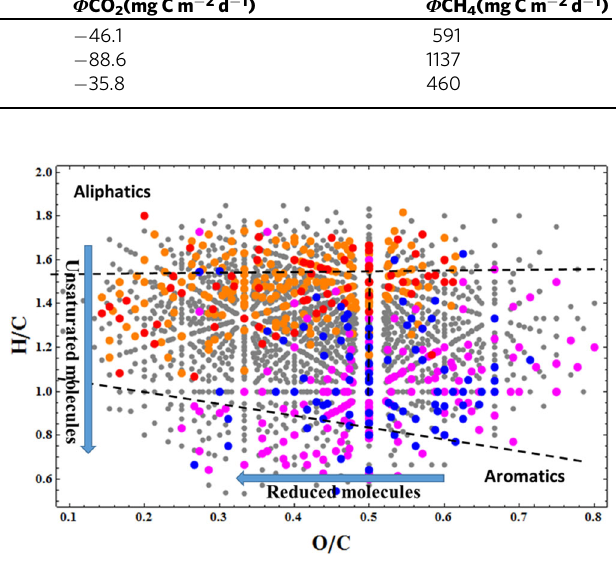
Fig. 3 Van Krevelen diagram of all SPE-DOM molecules identi fi ed with FT-ICR MS. The diagram cross-plots the hydrogen:carbon atomic ratio (H/C) as a function of the oxygen:carbon atomic ratio (O/C). The signi fi cance of Spearman correlation between relative abundances of molecules and methane concentration is indicated by the different colors, as follows: Gray = No signi fi cance ( p >0.01); Red = positive signi fi cant correlation ( p <0.005); Orange = positive signi fi cant correlation (0.005< p <0.01); Blue = negative signi fi cant correlation ( p <0.005); Magenta = negative signi fi cant correlation (0.005< p